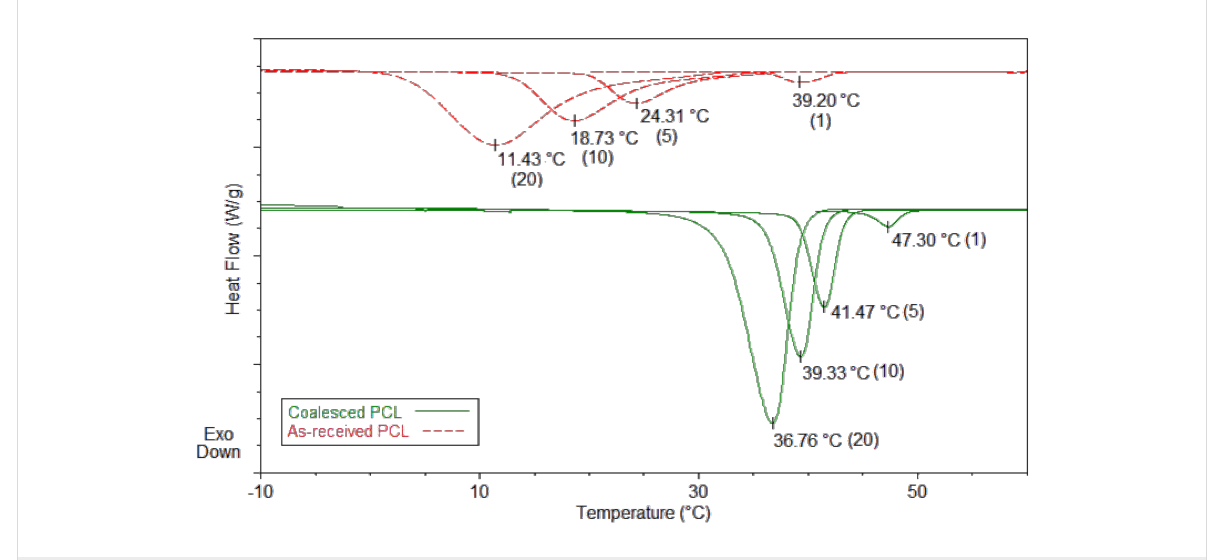
Figure 5: Melt-crystallization curves of as-received and coalesced PCL observed at 20, 10, 5, and 1 °C/min cooling rates [65].